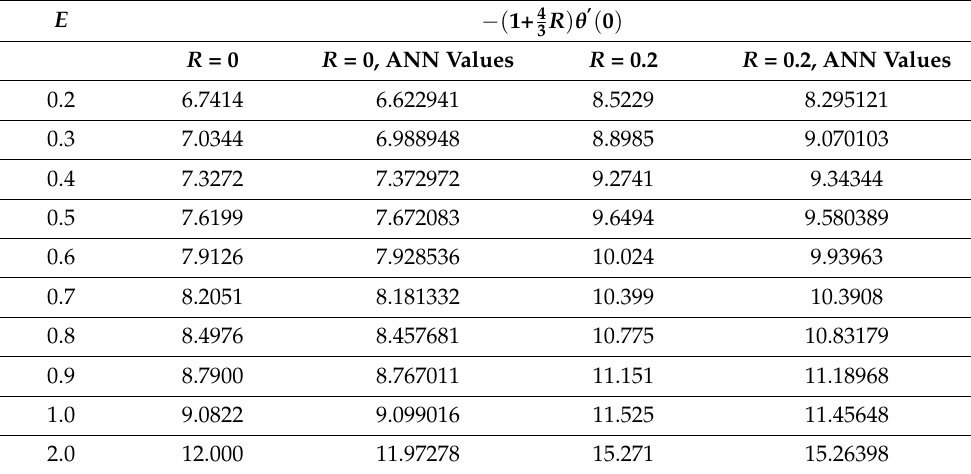
Table 8. Impact of Eckert number on Nusselt number for non-radiative and radiative flow fields.